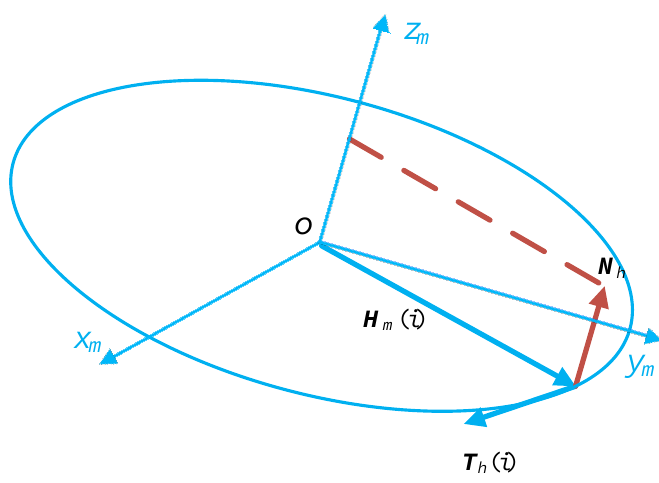
Figure 3. The diagram of measured data.